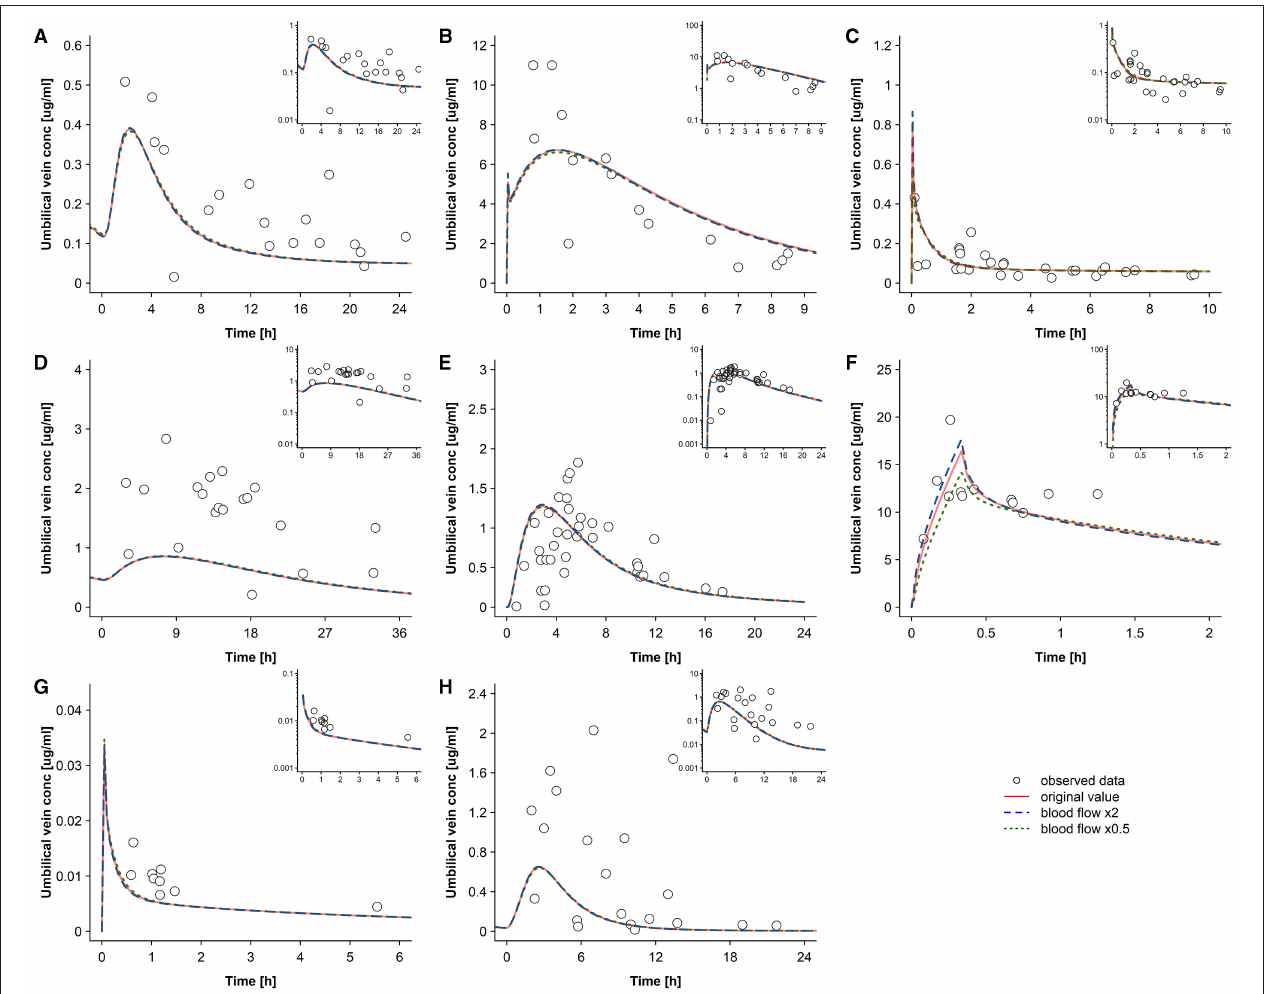
FIGURE 5 | Sensitivity analysis for the maternal placental blood flow rate. Concentration-time profiles in the umbilical vein plasma for acyclovir (A) , cefuroxime (B) , diazepam (C) , dolutegravir (D) , emtricitabine (E) , metronidazole (F) , ondansetron (G) , and raltegravir (H) at delivery in the third trimester. Semi-log scaled figures are shown as inset plot in the top-right corner of each panel. The time refers to the time after drug administration. Circles represent individual observed data and the lines represents the predicted geomean concentrations with different blood flow rates to the maternal placenta. Observed data for acyclovir, cefuroxime, diazepam, dolutegravir, emtricitabine, metronidazole, ondansetron, and raltegravir were taken from Liu et al. (18), Leung et al. (39), Hirt et al. (40), Philipson and Stiernstedt (41), De Leeuw et al. ( 42), Elkomy et al. (43), Visser and Hund (44), Moore and McBride (45), Ridd et al. (46), and Mandelli et al. (47), respectively. conc,